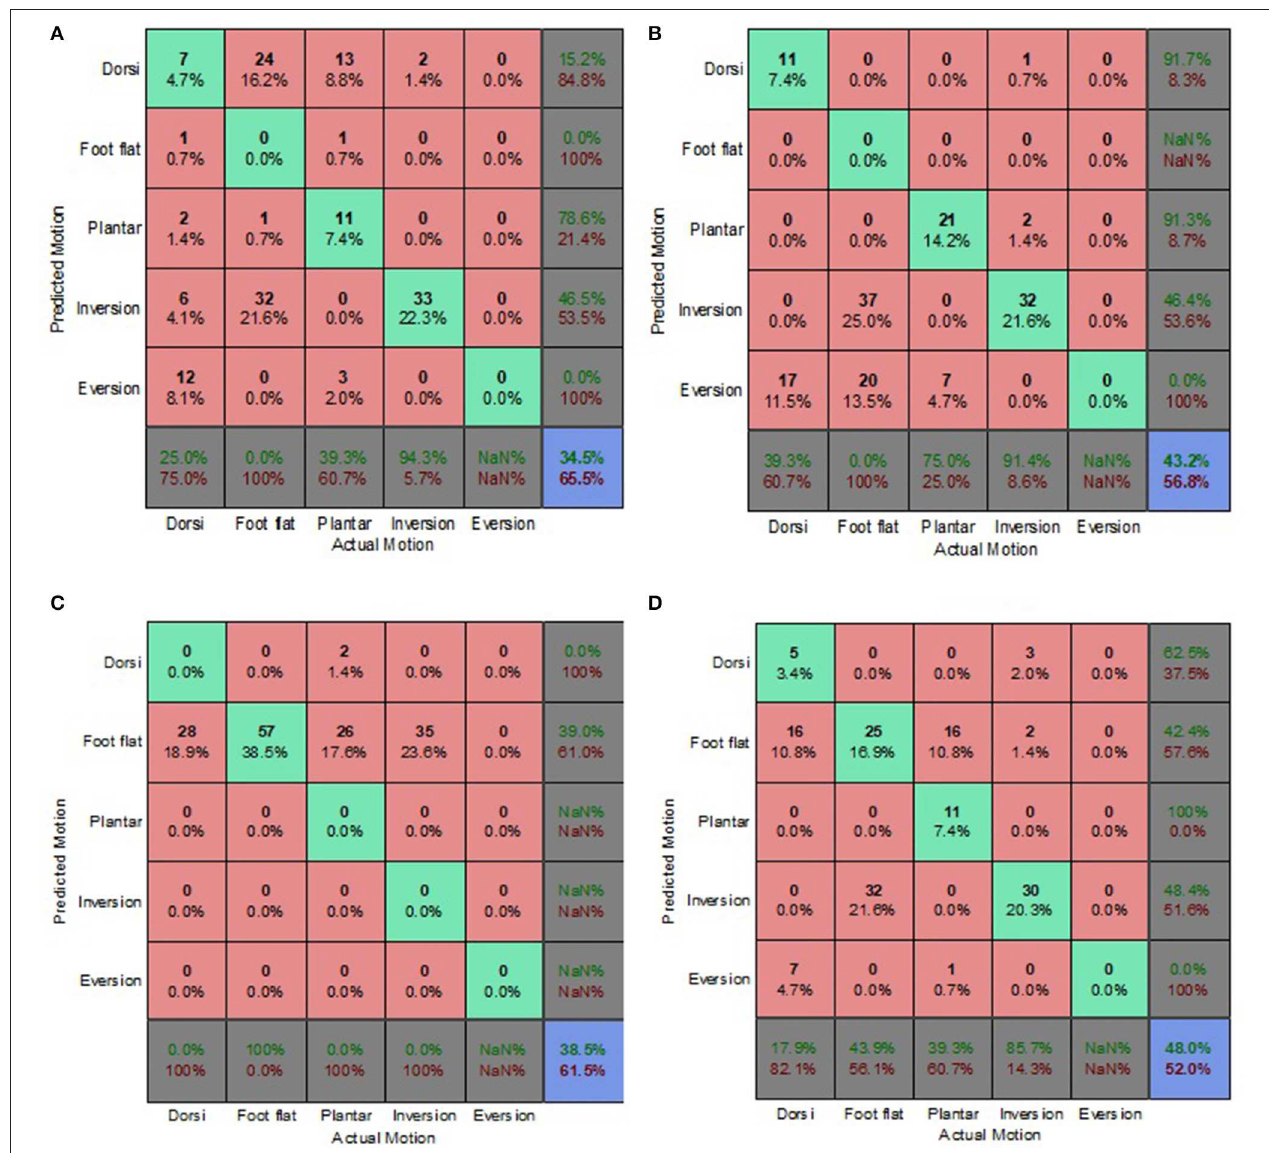
FIGURE 4 | Optimal Condition Combined Data Set—Biased Generic Approach. (A) Tree, (B) LDA, (C) Deterministic, and (D) Voting